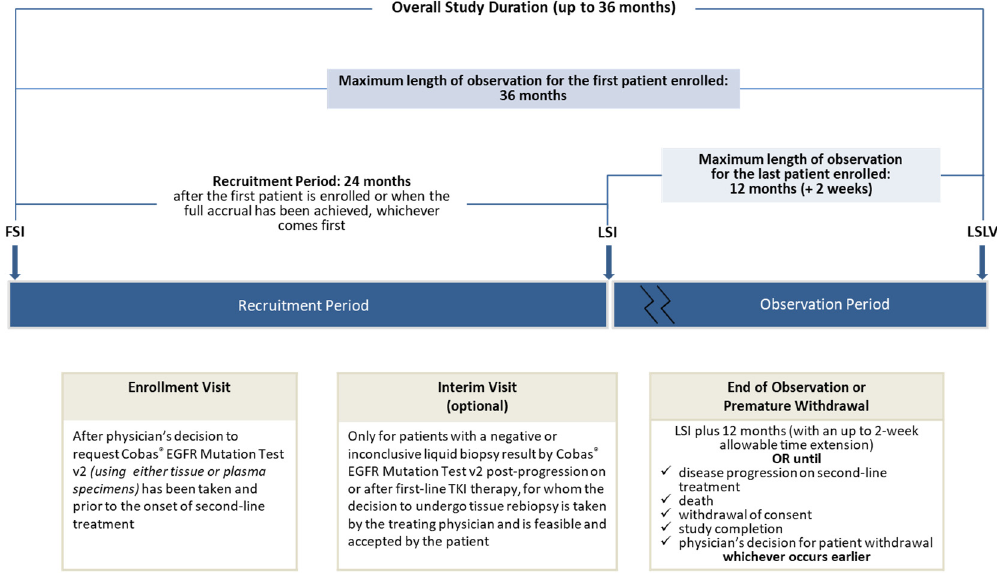
Figure 1. Overview of the study design. FSI: First Subject In; LSI: Last Subject In; LSLV: Last Subject Last Visit.